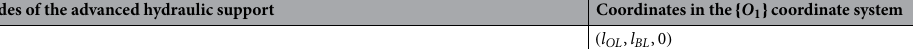
Table 1. Coordinates of node B in the { O 1 } coordinate system.